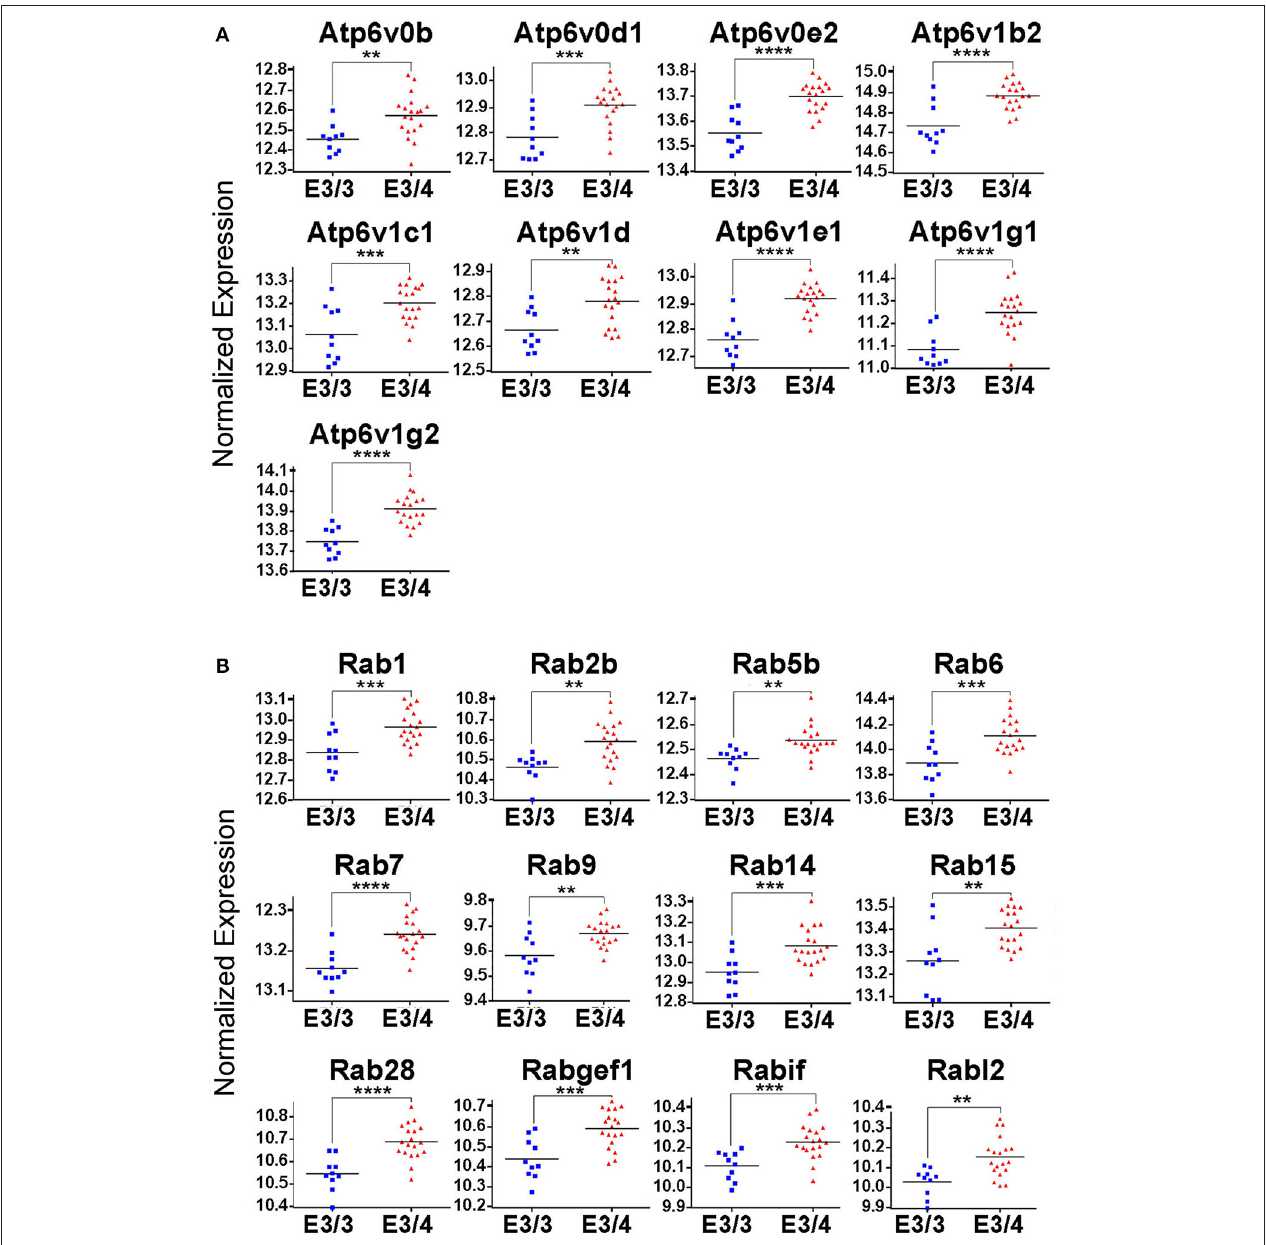
FIGURE 3 | Genes related to endosomal–lysosomal system function are upregulated in the EC of APOE3/4 mice. Our RNA-Seq analysis of EC genes from aged APOE3/4 vs. APOE3/3 mice revealed an enrichment of upregulated genes related to endosomal–lysosomal system function. (A) Differentially regulated V-type ATPases in the EC of APOE3/4 vs. APOE3/3 mice. (B) Differentially regulated Rab GTPases in the EC of APOE3/4 vs. APOE3/3 mice. (** p < 0.01; *** p < 0.001; **** p < 0.0001).